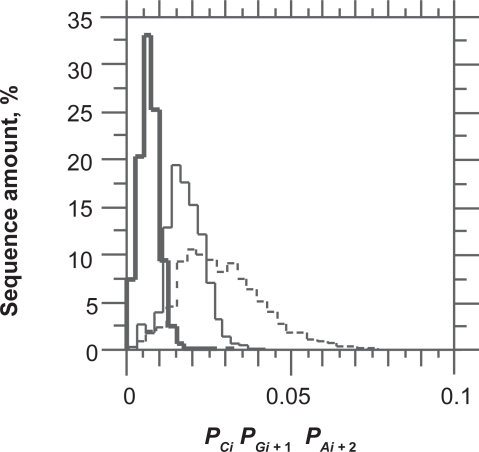
Distribution of PC1PG2PA3 (bold), PG1PA2PC3 (dashed) and PA1PC2PG3 (thin) in the coding sequences of O. sativa, A. thaliana, H. sapiens, D. melanogaster, C. reinhardtii and P. falciparum grouped together.